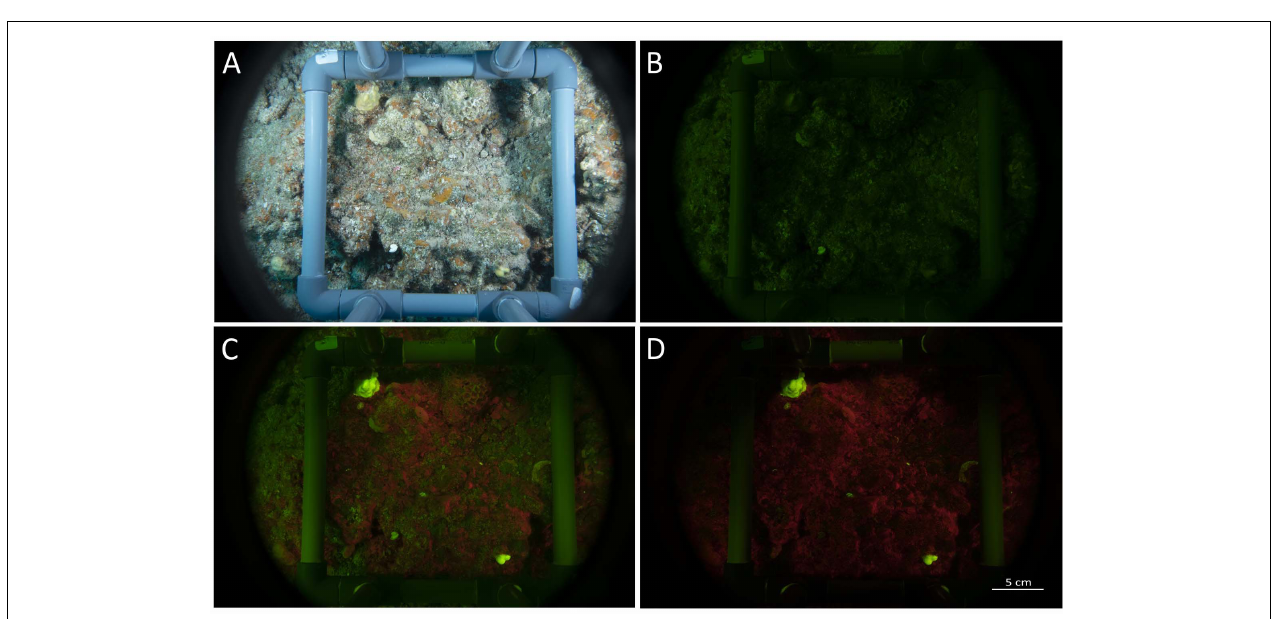
FIGURE 5 | Images set taken with the speed-FlorIS. (A) Reflectance image taken under white illumination, (B) ambient image (blue strobes off), (C) fluorescence image (blue strobes on), and (D) fluorescence image after subtracting image (B) from image (C) using Fiji software (Schindelin et al., 2012).